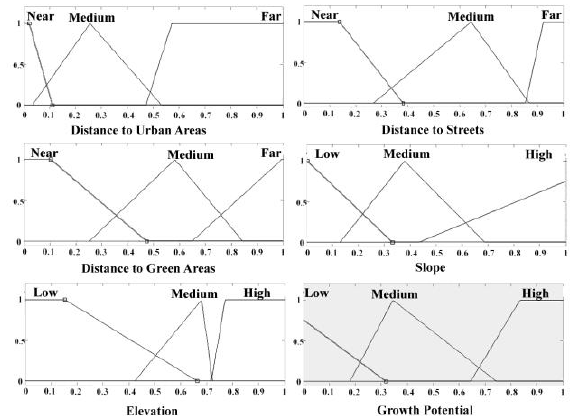
Figure 7. Calibrated fuzzy membership functions of inputs and